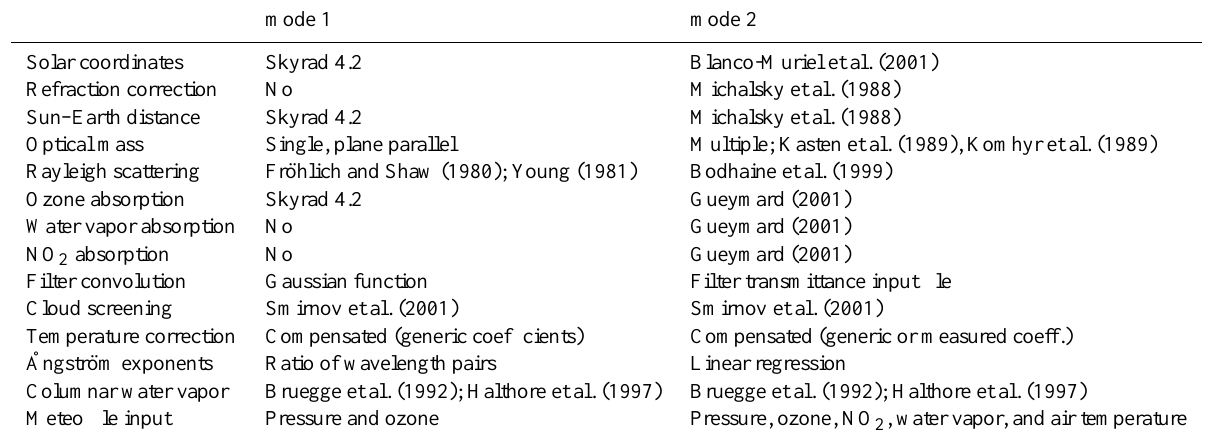
Table 2. Relation of algorithms implemented in the sunrad module in modes 1 and